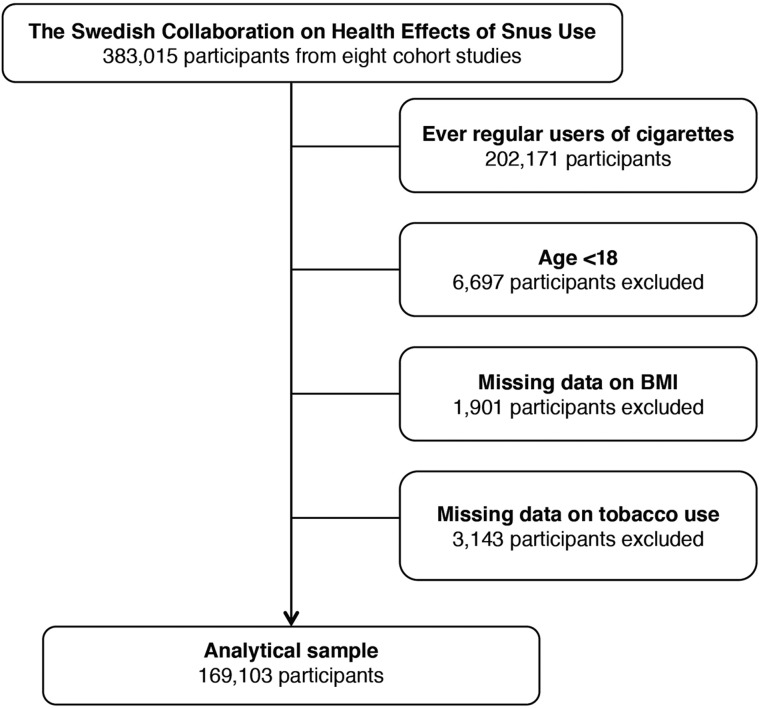
Exclusion of participants